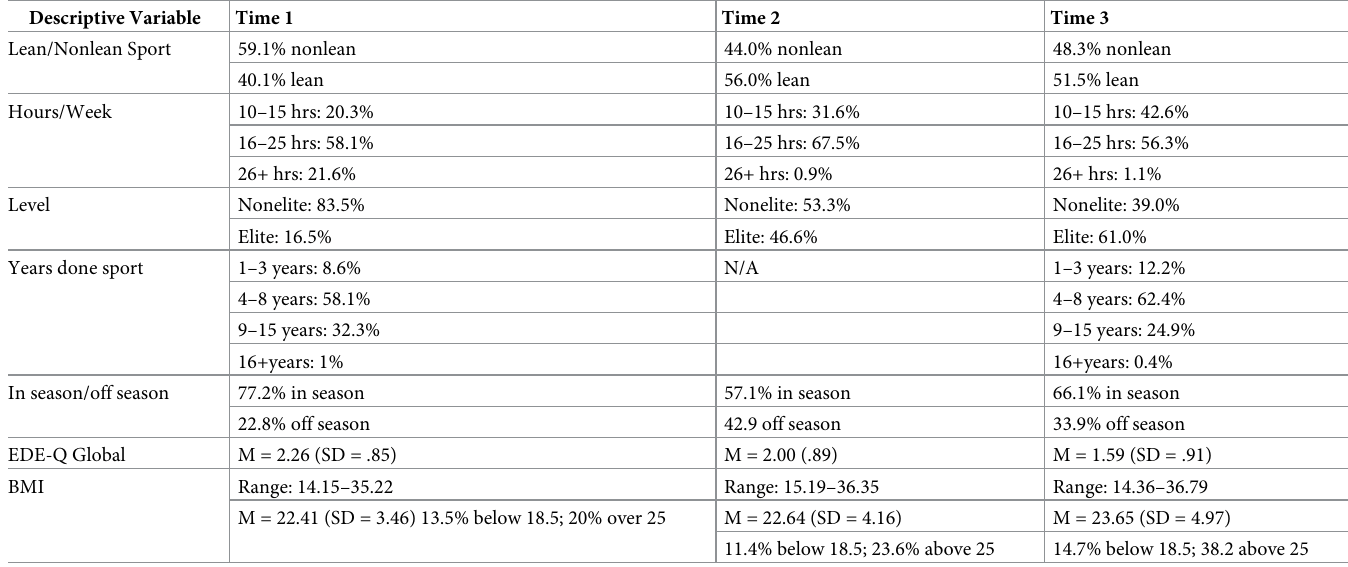
Table 1. Descriptive statistics and clinical